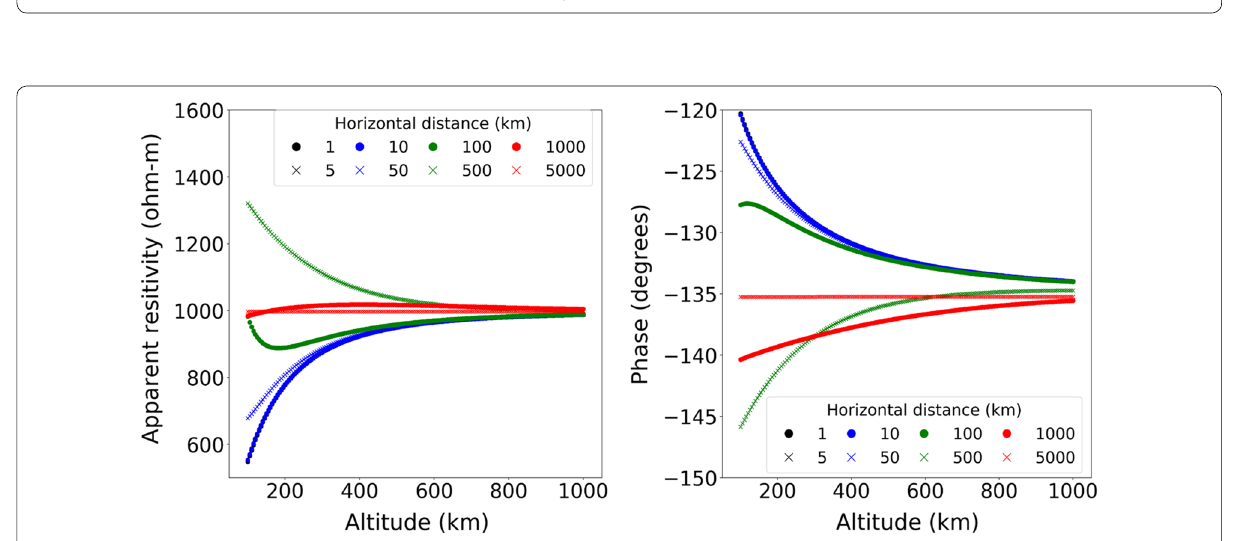
Fig. 4 As for Fig. 2 except the period is set to 200